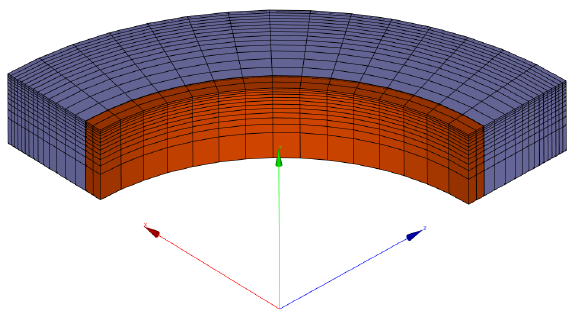
Figure 10. Mesh for hygro-mechanical model showing the restraining steel ring in red and mortar ring in blue.